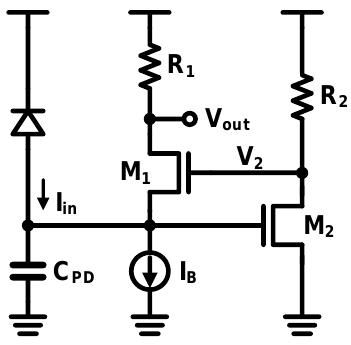
Figure 23. Regulated-cascode TIA.